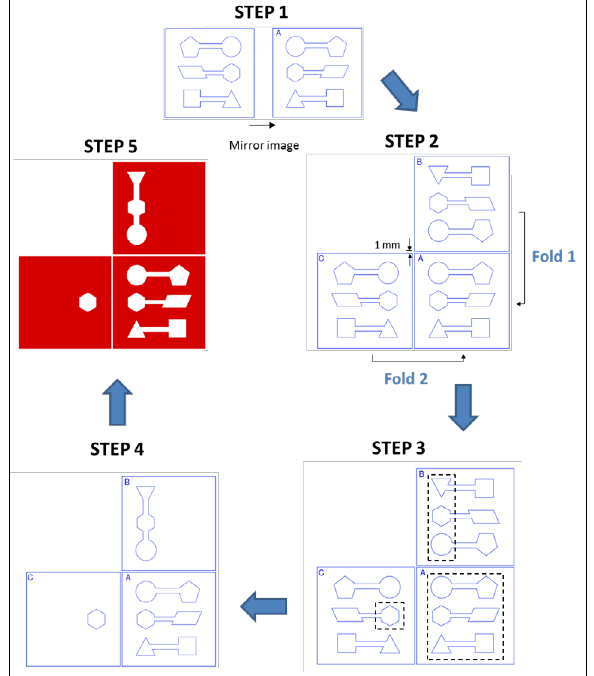
Figure 1: Illustration of design steps carried out to create an origami 3D paper fluidic device. STEP 1 shows the paper device design outline, which is mirrored to create layer A. STEP 2 illustrates further mirroring of the design to create two extra layers, B and C, for a three-layered paper device. STEP 3 highlights the vertical fluidic flow pathways required through the device (dotted lines) for the fluid to be introduced to the top layer, C, flow through to the middle layer, B, and onto the bottom layer, A. By deleting the design sections that fall outside the dotted lines, the final design is realised, as shown in STEP 4. The design is then shaded in the areas where the wax will be printed, leaving the fluidic flow pathways open, as shown in STEP